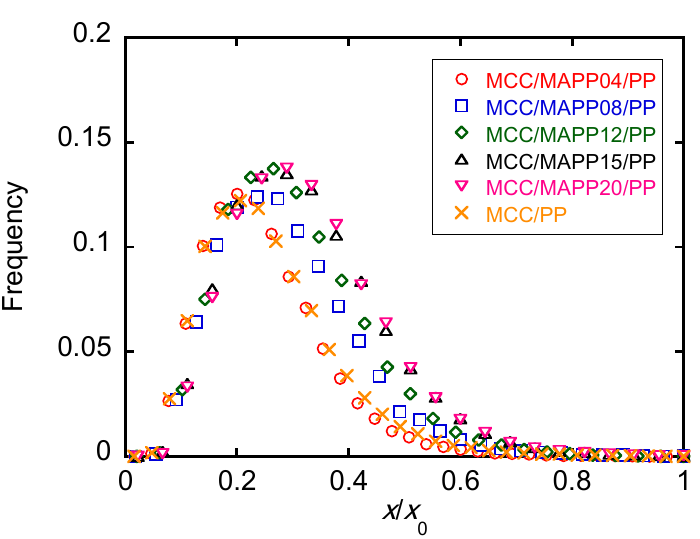
Figure 17. Histogram of the (distance between the centroids)/(maximum distance between the centroids) (= x / x 0 ) for the filler particles of the MCC/MAPP/PP composite (weight ratio, 22.5/2.5/75). Reprinted from Ref. [42]. Copyright Elsevier Ltd. (2020).